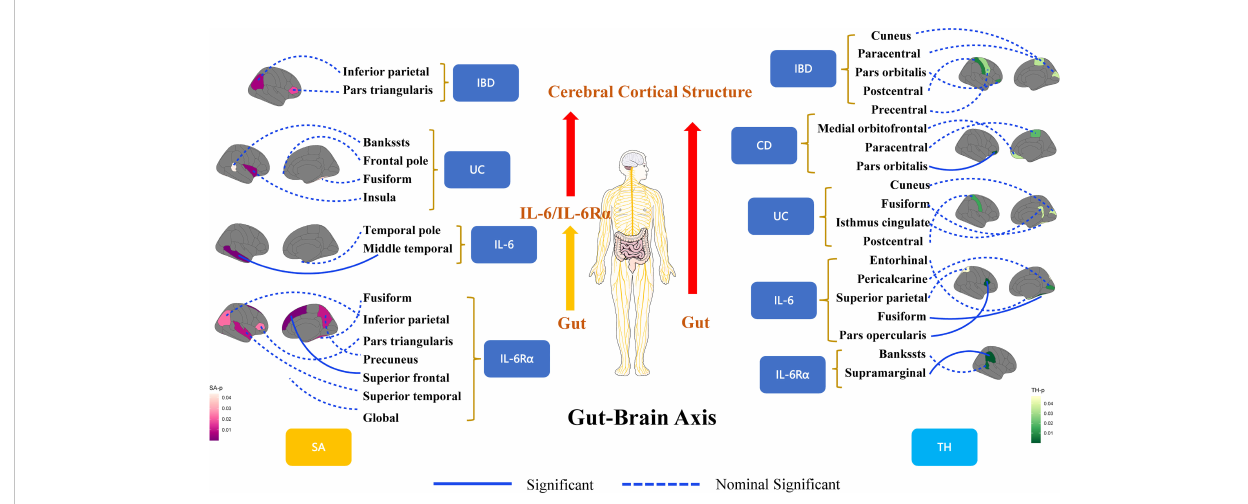
FIGURE 3 A framework for visualizing the results of Mendelian randomization analysis for revealing the connections of the gut-brain axis at the organic level. IBD, in fl ammatory bowel disease; CD, Crohn ’ s disease; UC, Ulcerative colitis; IL-6, interleukin 6; IL-6R a , interleukin-6 receptor subunit alpha; SA, surface area; TH,